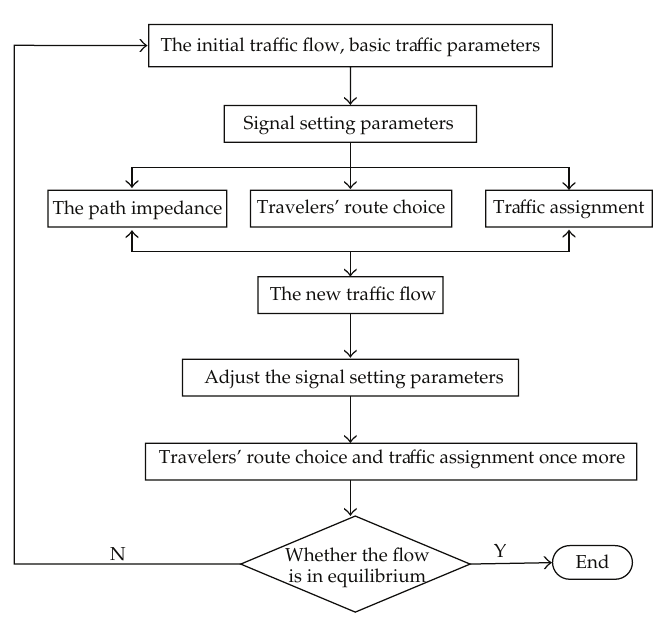
Figure 1: The relationship between signal setting and flow